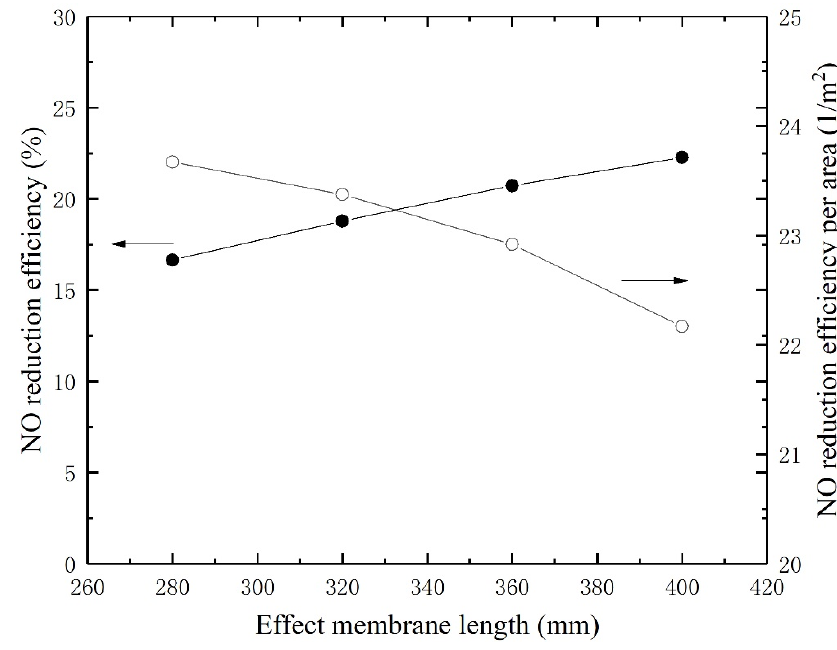
Figure 10. NO reduction and efficiency as a function of fiber